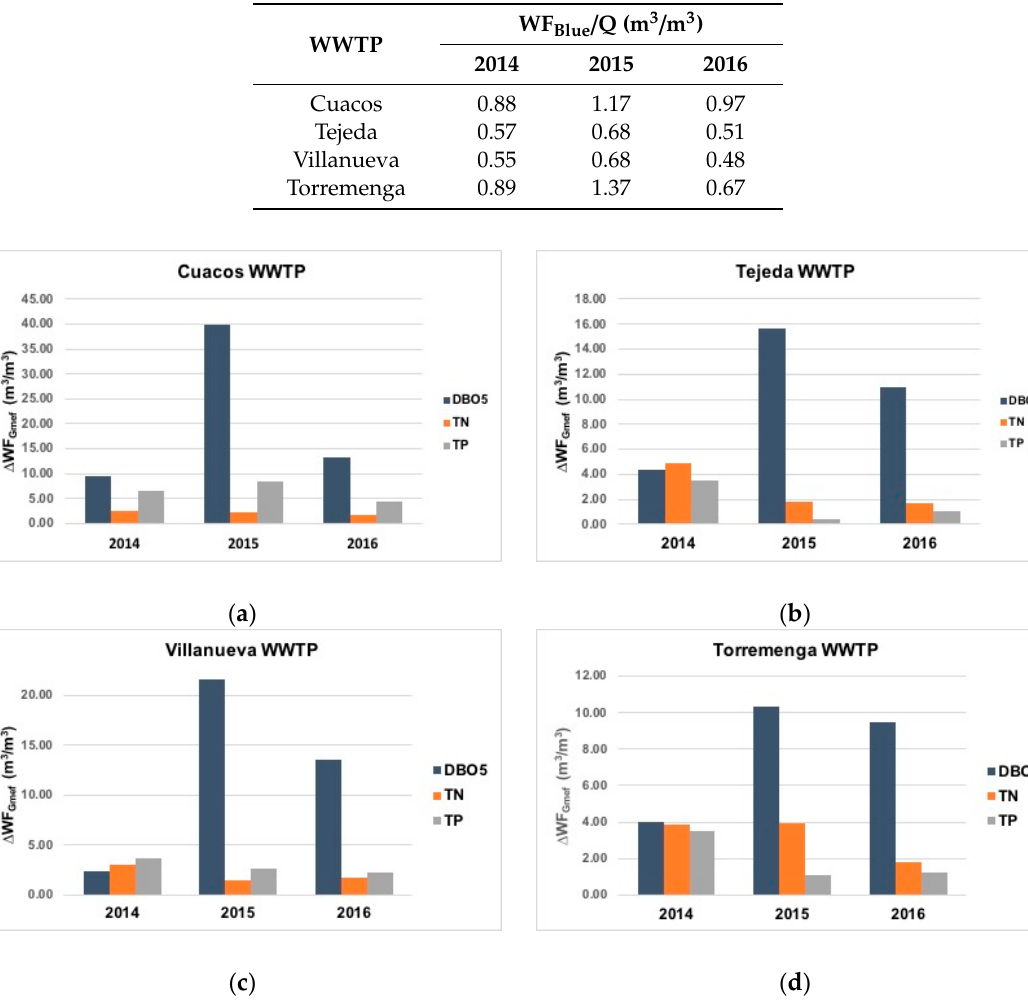
Figure 5. Average values of ∆ WFG ,mef per cubic metre of treated water to BOD5, TN and TP in 2014, 2015 and 2016 at four WWTPs: ( a ) Cuacos, ( b ) Tejeda, ( c ) Villanueva and ( d ) Torremenga.